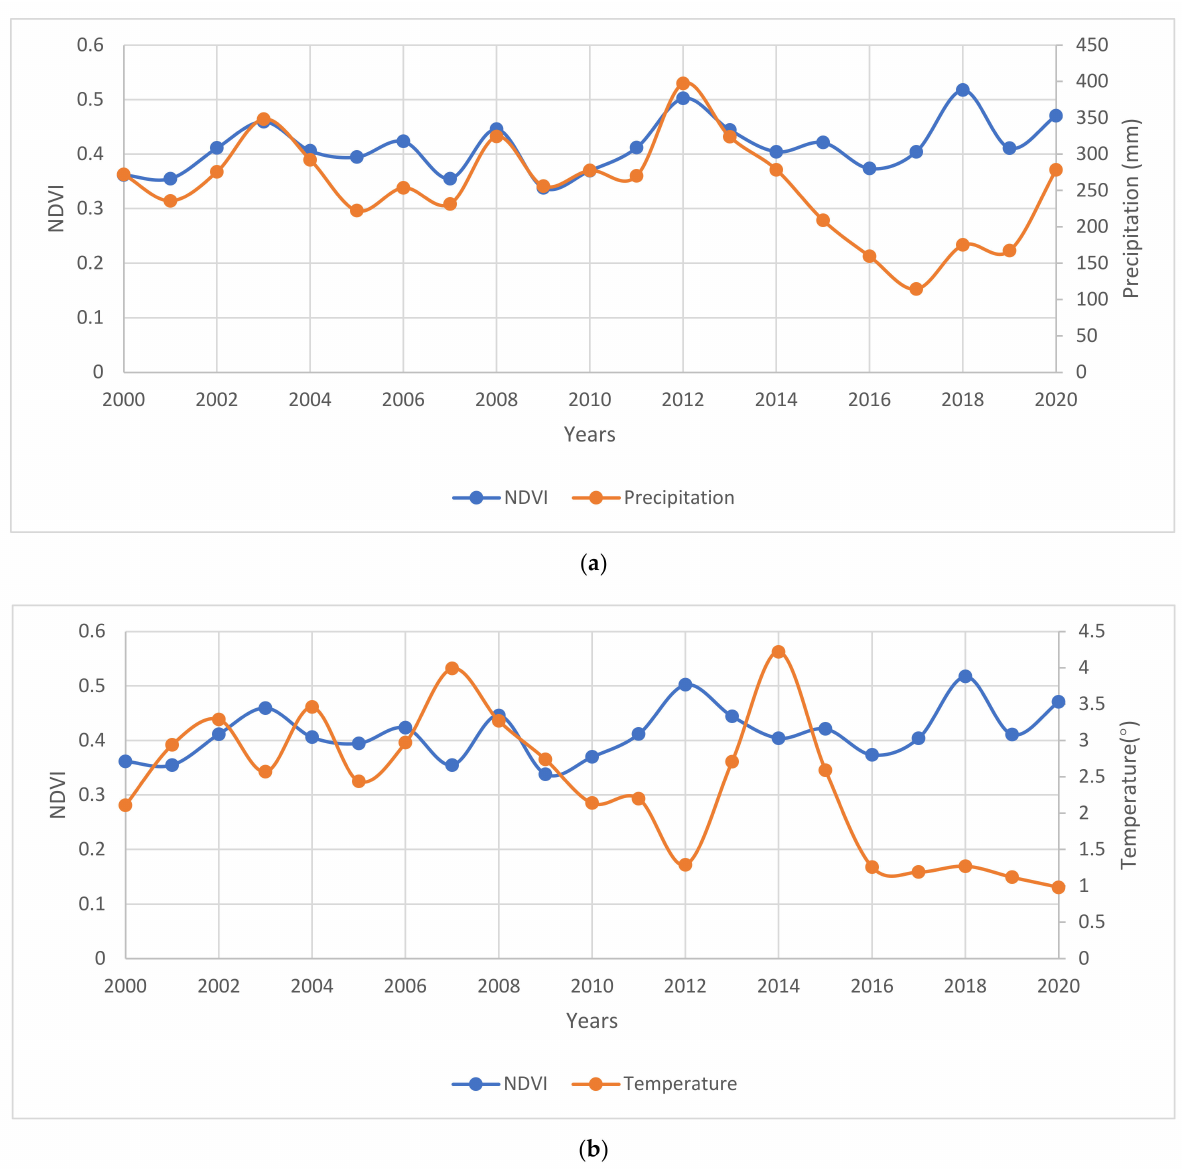
Figure 7. Fluctuation of the mean value of the NDVI and the mean value of the climatic elements in the study area from 2000 to 2020: ( a ) precipitation and ( b )